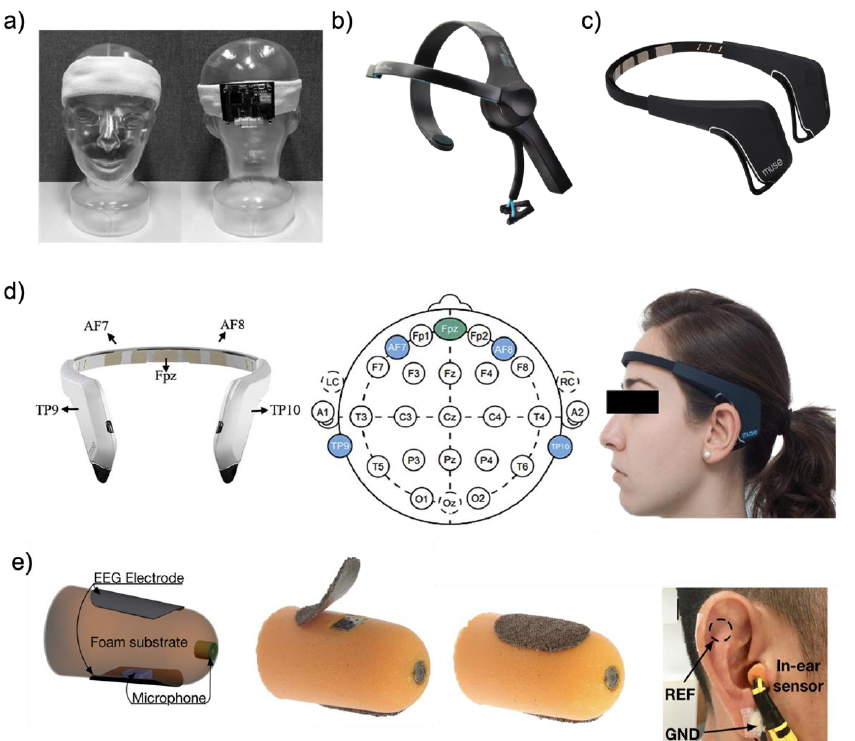
Figure 7. Examples of headband platforms and earplugs with electrodes. ( a ) Example of headband